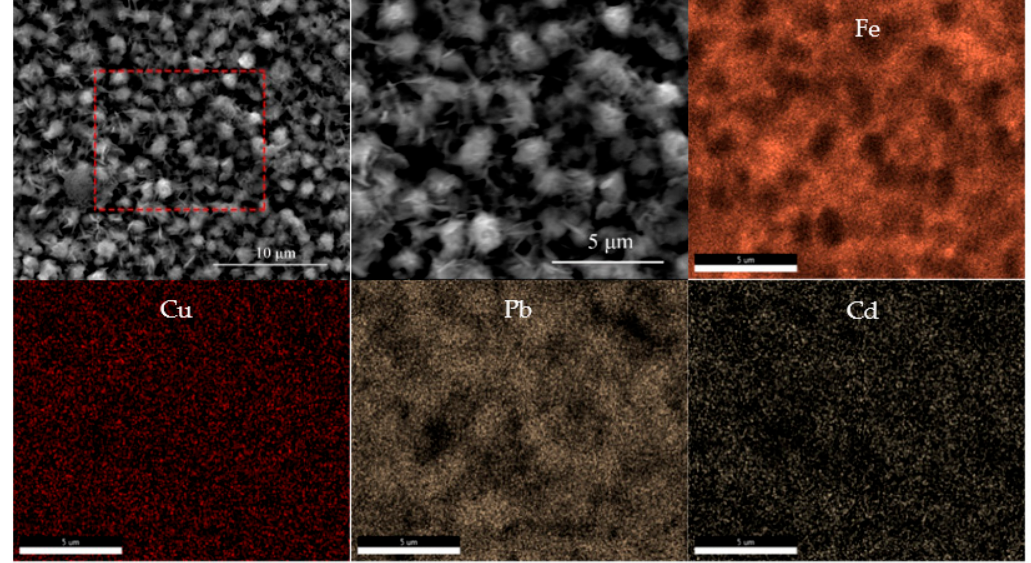
Figure 7. SEM of the cathode surface deposited at − 0.9 V for 120 min.